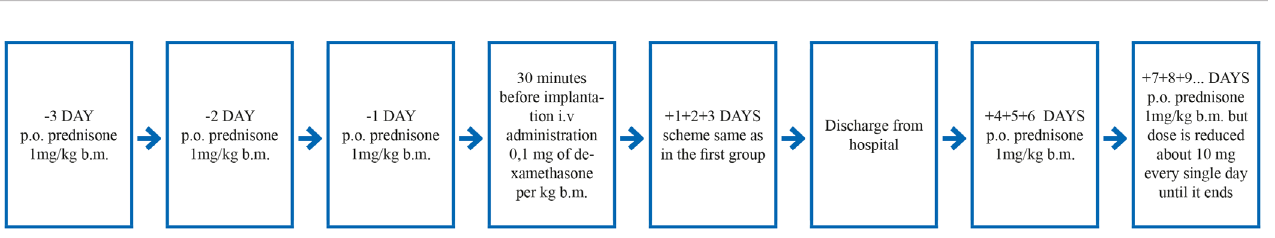
FIGURE 3 - Scheme of administration of corticosteroids in the second subgroup. The control subgroup of patients (N = 17) underwent a standard cochlear implantation procedure without steroid